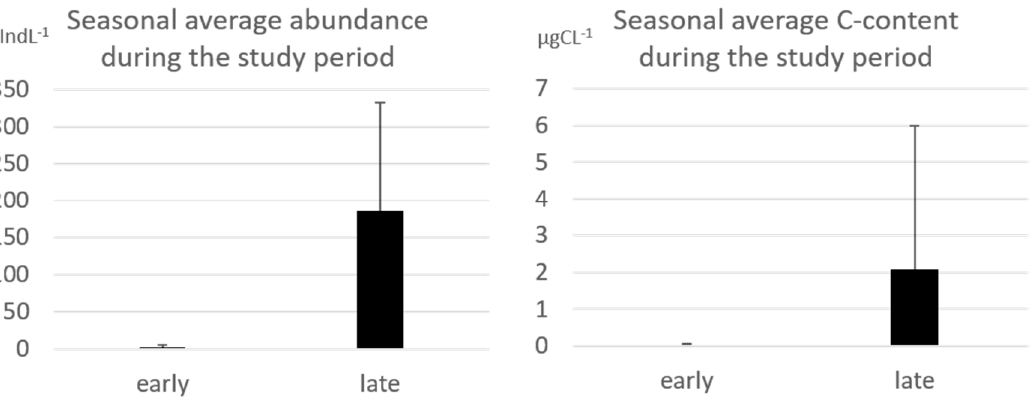
Figure 2. Average abundance of tintinnids (indL − 1 ) and average tintinnids carbon content (µgCL − 1 ) in the study area detected in the totality of early summer samples (early: December) and late summer samples (late: January and February); bars represent standard deviation ( sd ); early n = 39, late n = 282.